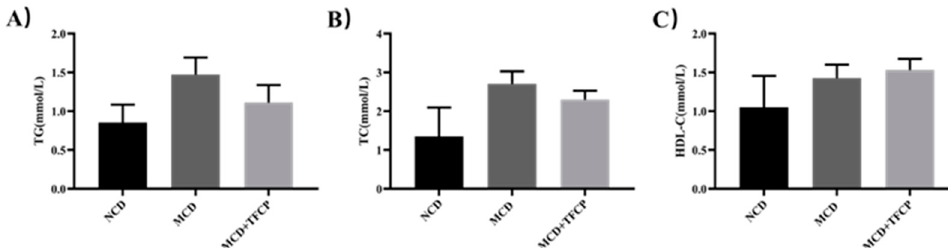
Figure 2. TFCP normalized the altered lipid profile of the studied group. Mice were fed with MCD or the control diet for six weeks, while the intragastric administration of TFCP to the MCD-fed mice was performed daily. Lipid profiles including ( A ) TG, ( B ) TC, and ( C ) HDL-C levels were evaluated in the mice’s serum. The means ± SEM of the results in the graph were obtained using NCD ( n = 5), MCD diet-fed group ( n = 5), and MCD + TFCP ( n = 5). Data were shown as the mean ± SEM.